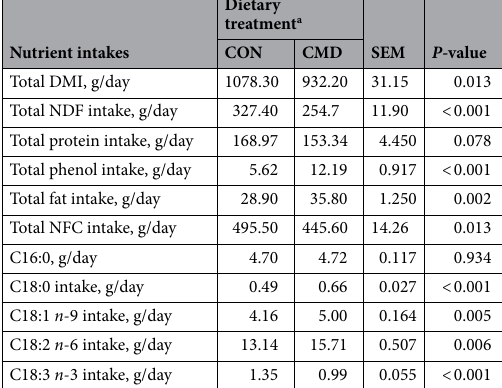
Table 2. Nutrient intakes of lambs fed concentrate diets containing dehydrated lucerne (CON) or cardoon meal (CMD). SEM pooled standard error of the mean, DMI dry matter intake, NDF neutral detergent fiber, NFC non-fiber carbohydrate. a CON control diet, CMD cardoon meal diet.